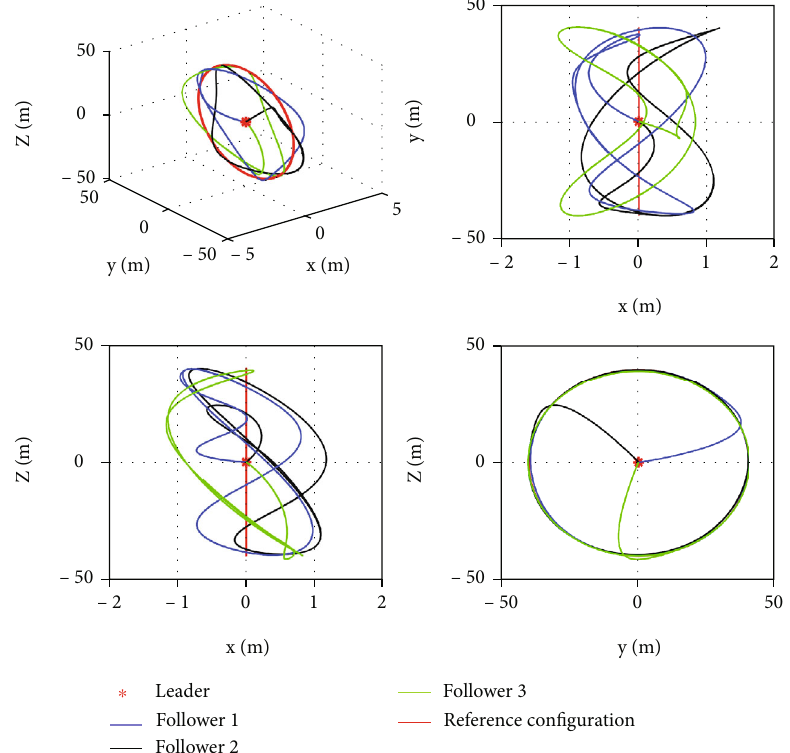
Figure 6: The trajectories of the followers relative to leader (PID).